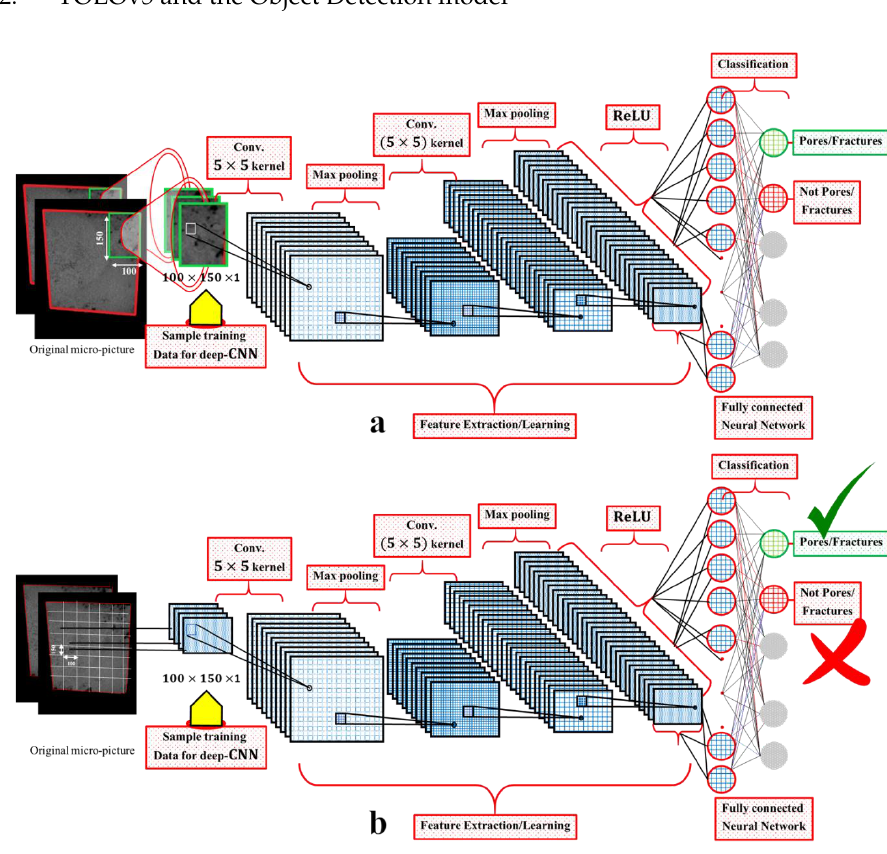
Figure 6. Base architecture of deep CNN adopted for various object detection experiments in the current work. ( a ) Training samples are enclosed in the green boxes of dimensions 100 × 150 × 1; ( b ) For testing, we read the consecutive regions, each containing 100 × 150 × 1 pixels for each testing image.